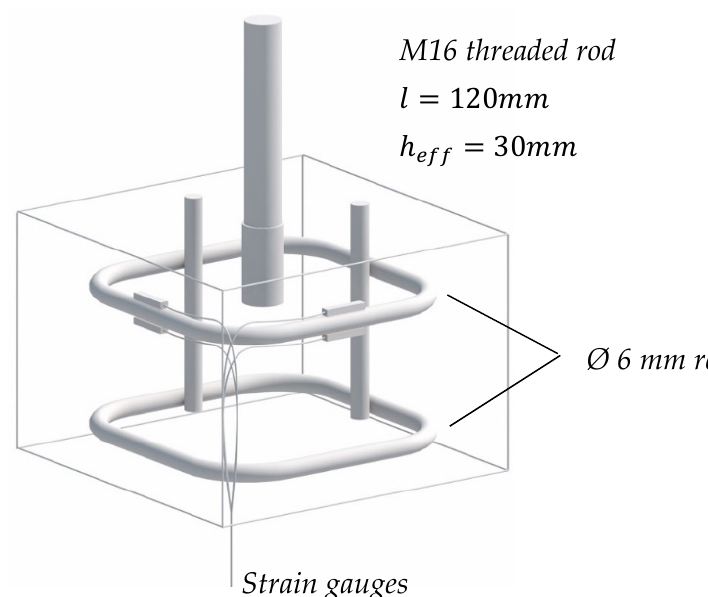
Figure 11. Radial stress measurement probe.